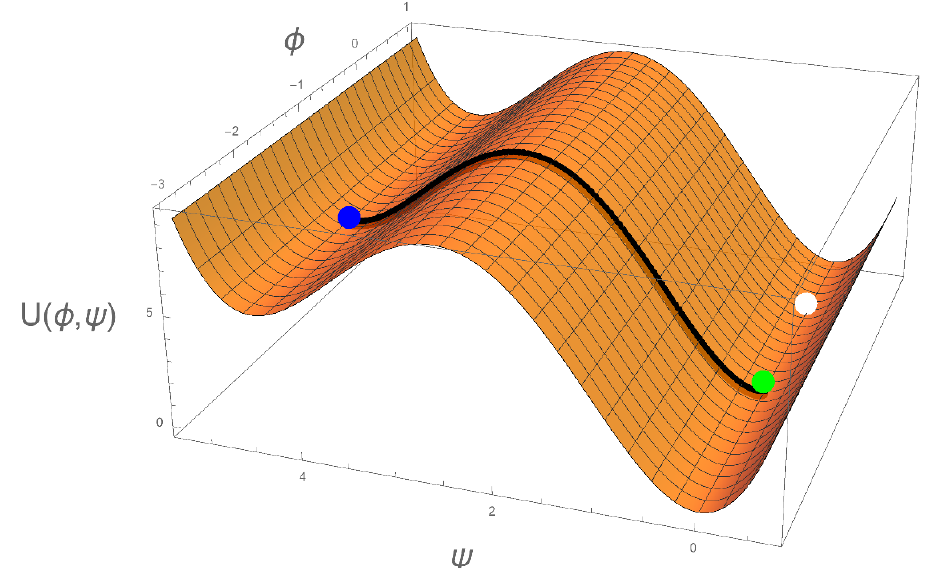
Figure 1 . An example of the potential (2.13), where we use the parameters indicated in the text. The false vacuum is marked by a blue dot. The black line shows the instanton trajectory, and the green dot is the tunneling point. We also show an in(cid:13)ection point with a white dot. nucleation. We assume that gravitational e(cid:11)ects on the tunneling can be neglected, which is usually the case for (cid:3) (cid:28) 1. The instanton trajectory is shown as a black line in the a (cid:12)gure, with the tunneling point indicated by a green